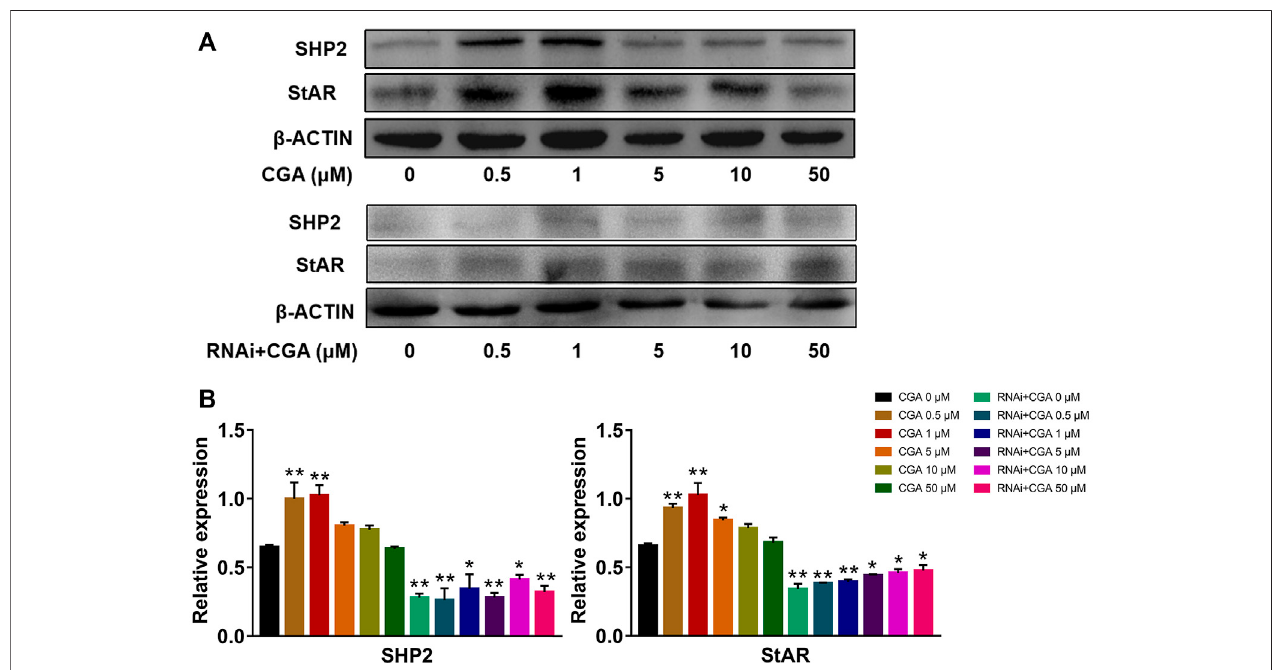
FIGURE8| CGA activated theSHP2-StAR signaling pathway. TM3cellsand Shp2 knockdownTM3cells(RNAi)werecultured withCGA(0.5,1,5,10and50 μ M) for 36 h, and gene expression was measured by Western blot. (A) Western blot analysis of the effect of CGA on the SHP2-StAR signaling pathway. (B) The results of statistical analyses. Values are expressed as the mean ± SD ( n = 3). * p < 0.05, ** p < 0.01 vs CGA 0 μ